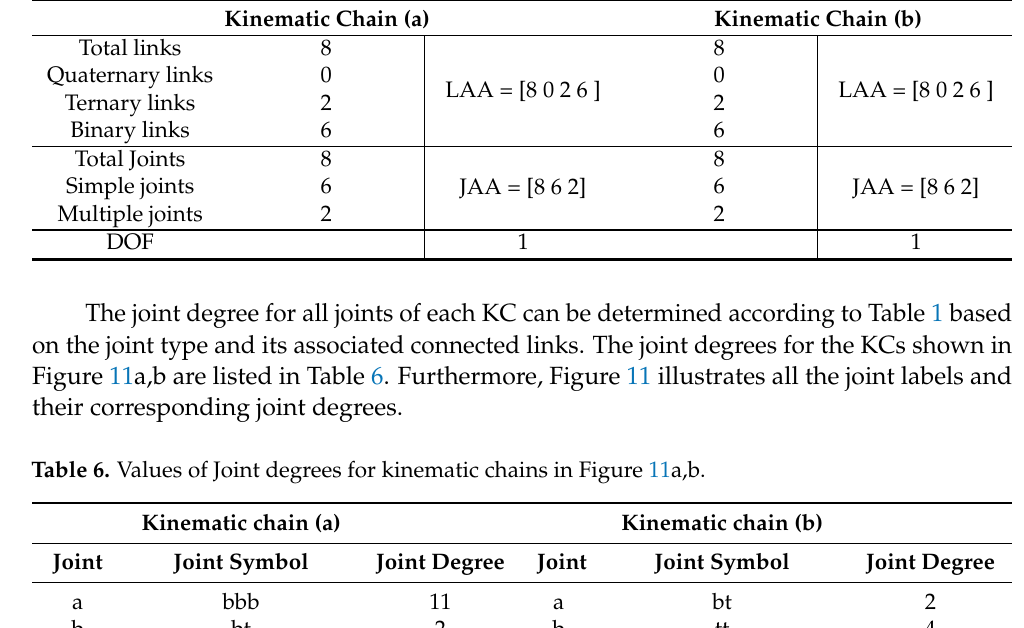
Table 5. Link Assortment Array and Joint Assortment Array for kinematic chains in Figure 11a,b.